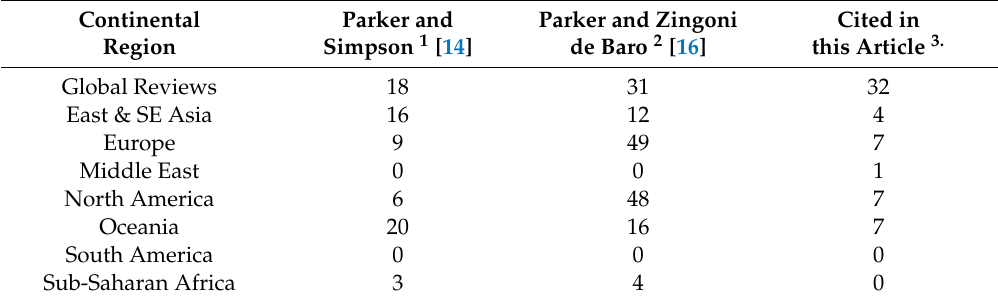
Table A1. Geographic distribution of case studies and sources of data that informed this